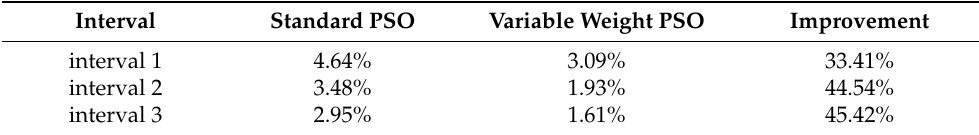
Table 4. Target interval accuracy improvement.